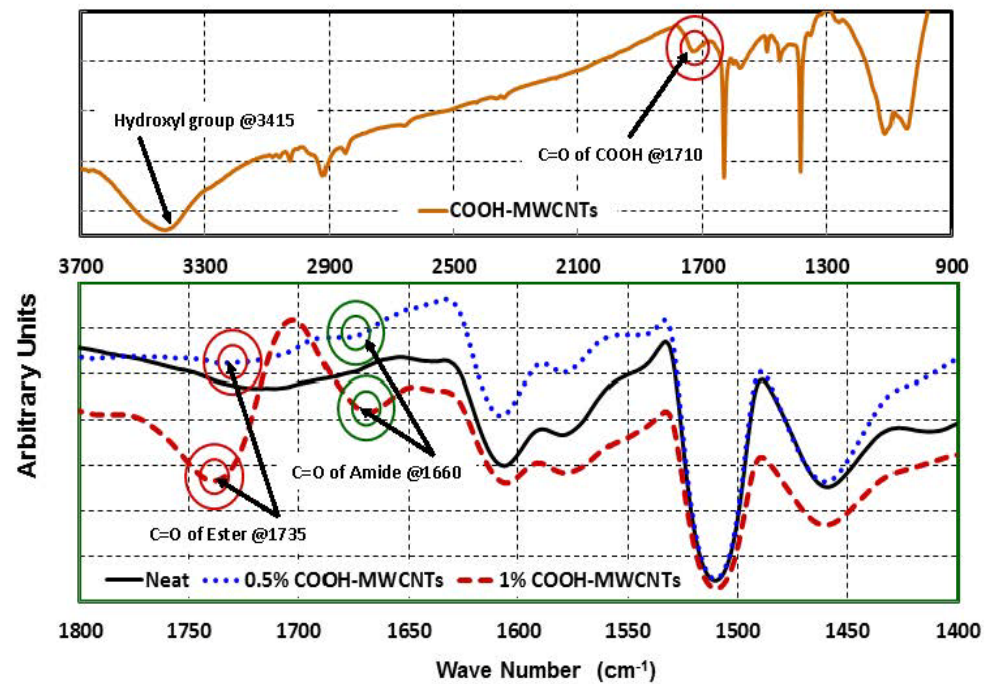
Figure 10. FTIR transmission curves of ( a ) COOH-MWCNTs powder and ( b ) COOH-MWCNTs/epoxy